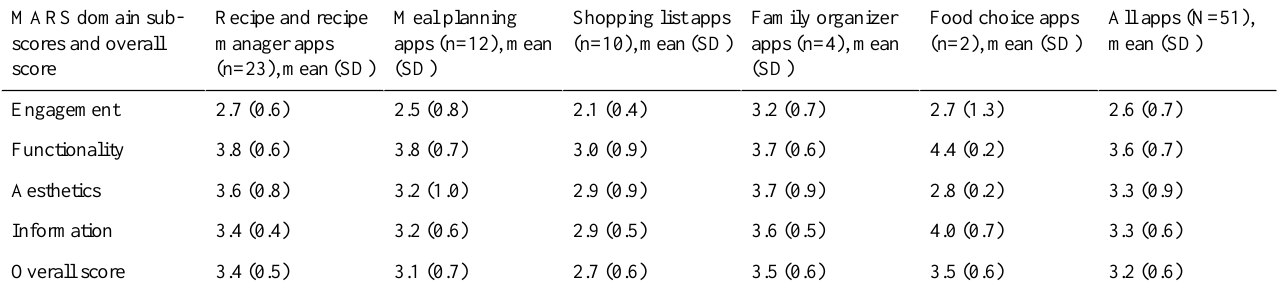
Table 1. Mean (SD) Mobile App Rating Scale (MARS) subscores and overall scores by app